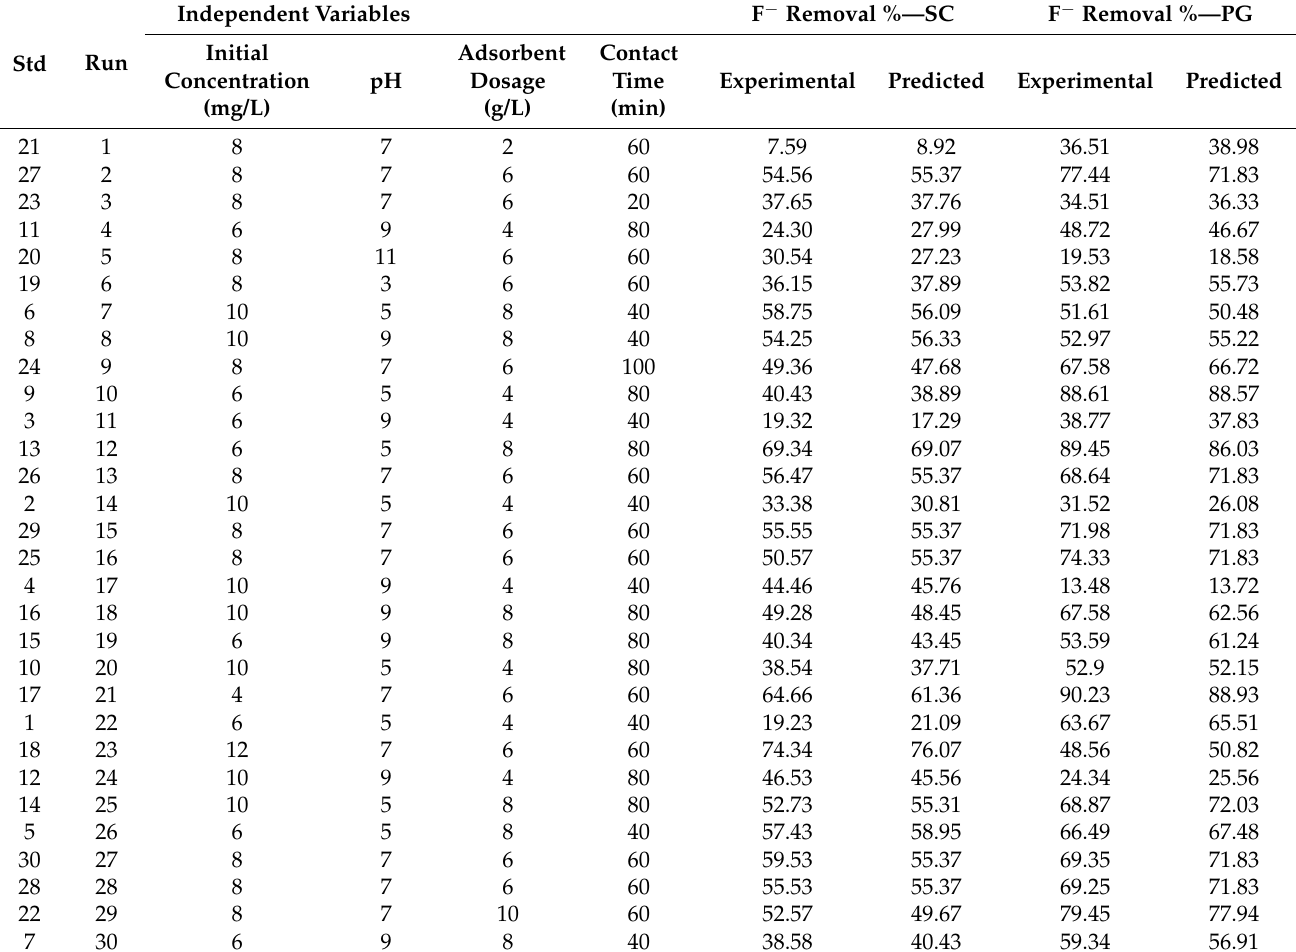
Table 3. Experimental design with experimental data and predicted values for both biosorbents.